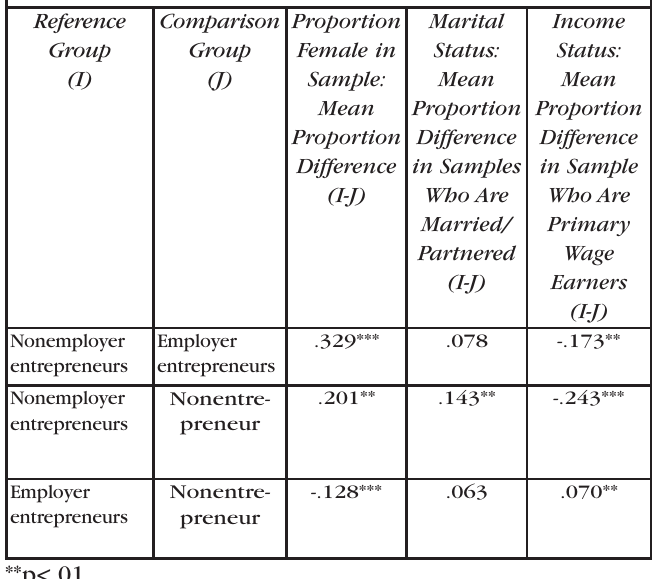
Table 6. Differences in Proportion of Samples Represented in Study Groups by Sex, Marital Status, and Income